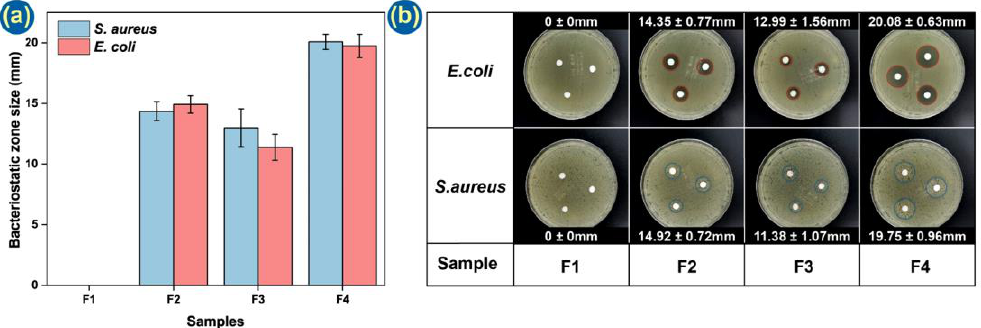
Figure 8. Antibacterial effects of the formulations. ( a ) Histogram and ( b ) photographs of the zones of inhibition.